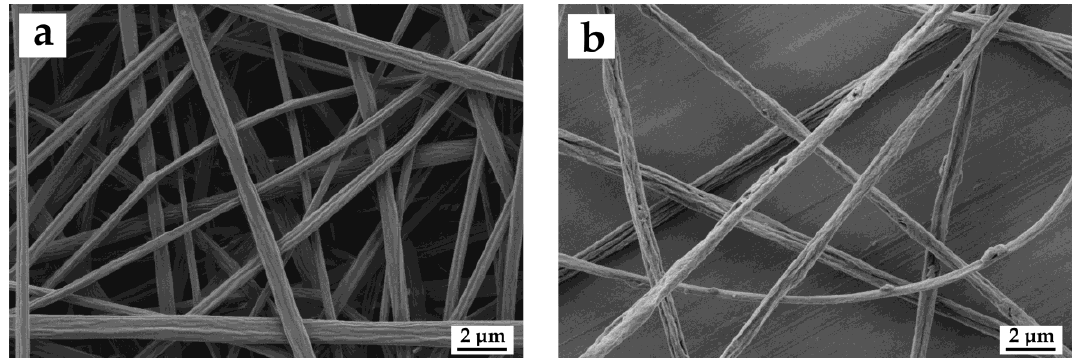
Figure 1. Field emission scanning electron microscopy (FESEM) micrographs of the electrospun fibers of: ( a ) Neat polylactide (PLA); and ( b ) PLA containing gallic acid (GA). Both images were taken at 5000× and scale markers of 2 µm.